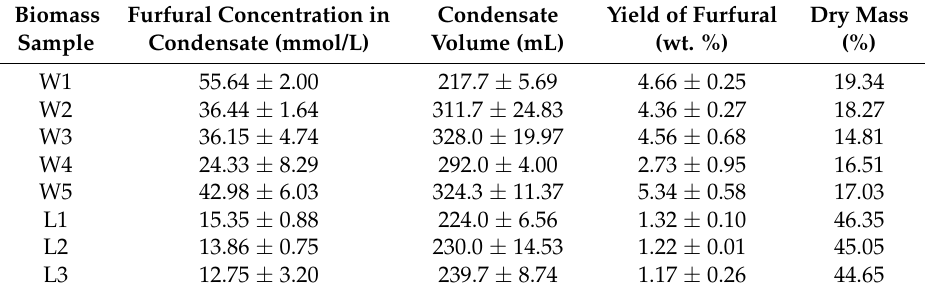
Table 2. Influence of ensilage and storage time on the concentration and volume of furfural obtained in distillates from waste